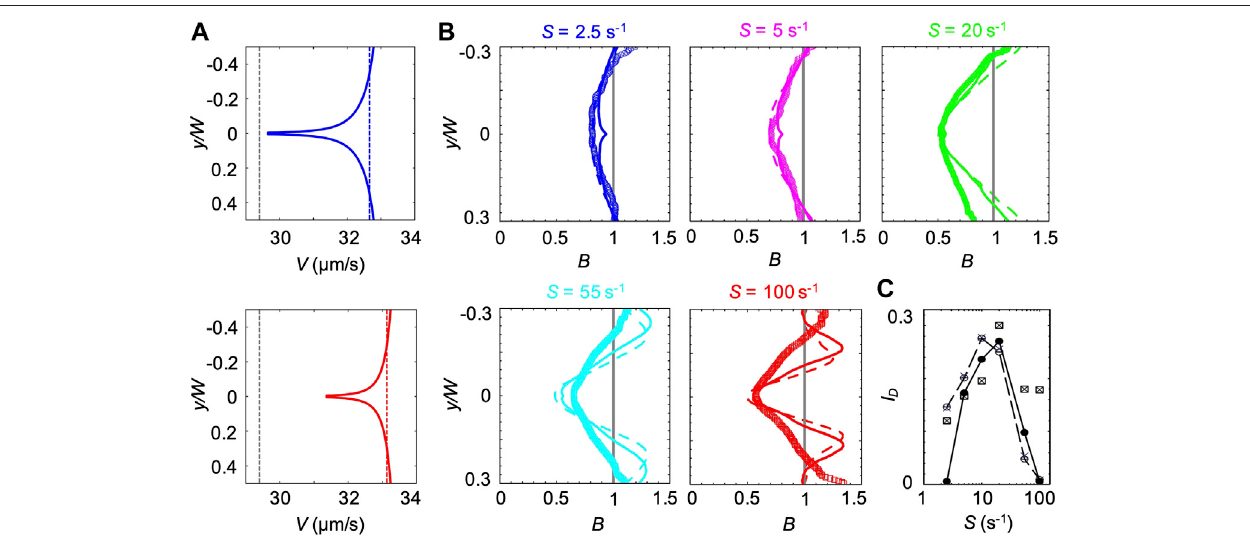
FIGURE8|(A) Bacterialswimmingvelocities V(y) (blueandredcurve), V ( η S )(blueandreddashedlines)and V 0.1% measuredinaxanthangumsolutionat0.1w/v% (grey dashed lines). Thevelocitiesarereportedfor meanshearrates S =2.5 s − 1 (upper panel) and S = 55 s − 1 (lower panel). (B) Concentration pro fi les B of P.aeruginosa fromexperiments(symbols)andfromthemathematicalmodel( V(y) solidlinesand V 0.1% dashed lines)formeanshearrates S =2.5(blue),5 s − 1 (pink), S =20 s − 1 (green), S = 55 s − 1 (light blue) and 100 s − 1 (red) in a xanthan gum solution at 0.1 w/v%. All the pro fi les were measured or computed at a distance D = 50 cm from the inlet and normalized bythemeanbacterialconcentrationintheno- fl owcase.Thenumericalconcentrationpro fi les wereobtainedbymodelingbacterialtransportinastraight 50 cm-longchannelusingtwodifferentdescriptionsforthebacterialswimmingvelocity( V(y) and V 0.1% ). (C) Thedepletionindex I D asafunctionofthemeanshearrate S , measured from the experimental (squares) and numerical ( V(y) , fi lled circles; V ( η S ), crosses; V 0.1% empty circles) bacterial concentration pro fi les reported in (B)